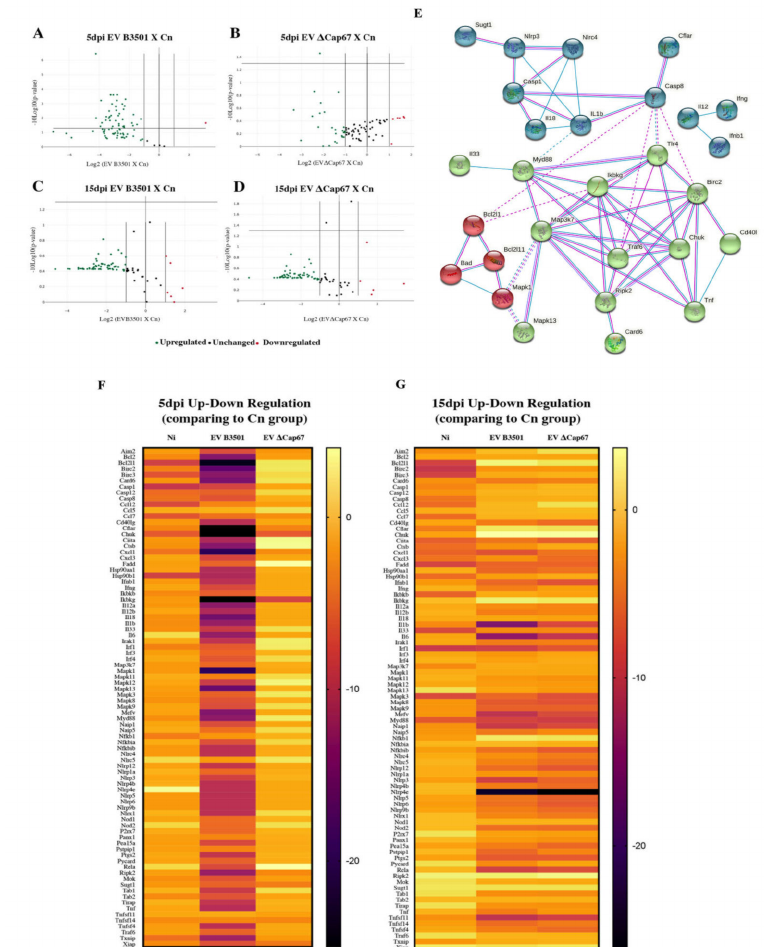
Figure 4. Treatment with EVs produced in a rich medium negatively modulated gene expression related to inflammasome activation in mice infected with C. neoformans at 5 and 15 dpi. C57Bl / 6 mice were infected with C. neoformans (2 × 10 4 cells / animal) intratracheally and treated intranasally with 50 µ g of EVs (protein content) produced in SDB 100%. Mice were treated one and three dpi and euthanized 5 dpi ( A , B , F ) or treated two and four dpi and euthanized 15 dpi ( C , D , G ). Lungs of the infected and treated mice were macerated with QIAzol Lysis Reagent bu ff er for RNA extraction using RNeasy mini-kit (Qiagen). RNA was converted to cDNA using the RT 2 First Strand Kit (Qiagen), which was used to detect di ff erentially expressed genes in the lungs using the kit “Mouse Inflammasomes RT 2 Profiler PCR Array” (Qiagen). The Volcanos Plot compared gene expression in the treated group with untreated groups and identified significant gene expression changes by plotting the log2 of the fold changes in gene expression on the x-axis versus their statistical significance on the y-axis. The center vertical line indicates unchanged gene expression, while the two outer vertical lines indicate the selected fold regulation threshold. The horizontal line indicates the p -value threshold (1,3). Genes with data points in the far upper left (down-regulated) and far upper right (up-regulated) sections meet the selected fold regulation and p -value thresholds ( A – D ). Network analysis of interacting inflammasome genes separated in color clusters of more related genes produced using String online software ( E ). The heatmaps show up and down-regulation on gene expression in the lungs of treated mice compared with untreated ( F – G ). The experiment was performed with biological triplicates and are representative of at least three independent